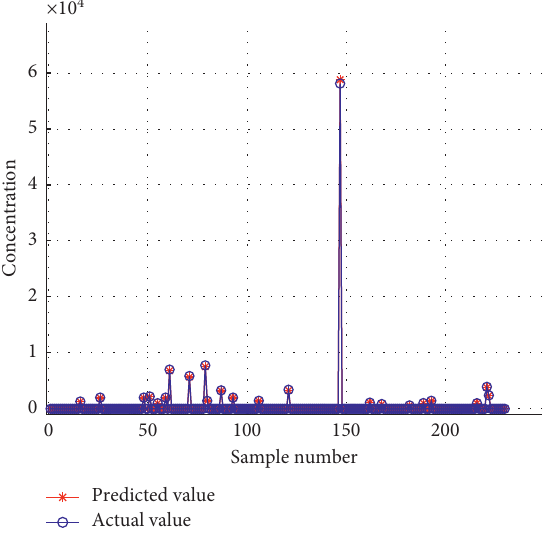
Figure 11: The Jining test set data prediction effect diagram.